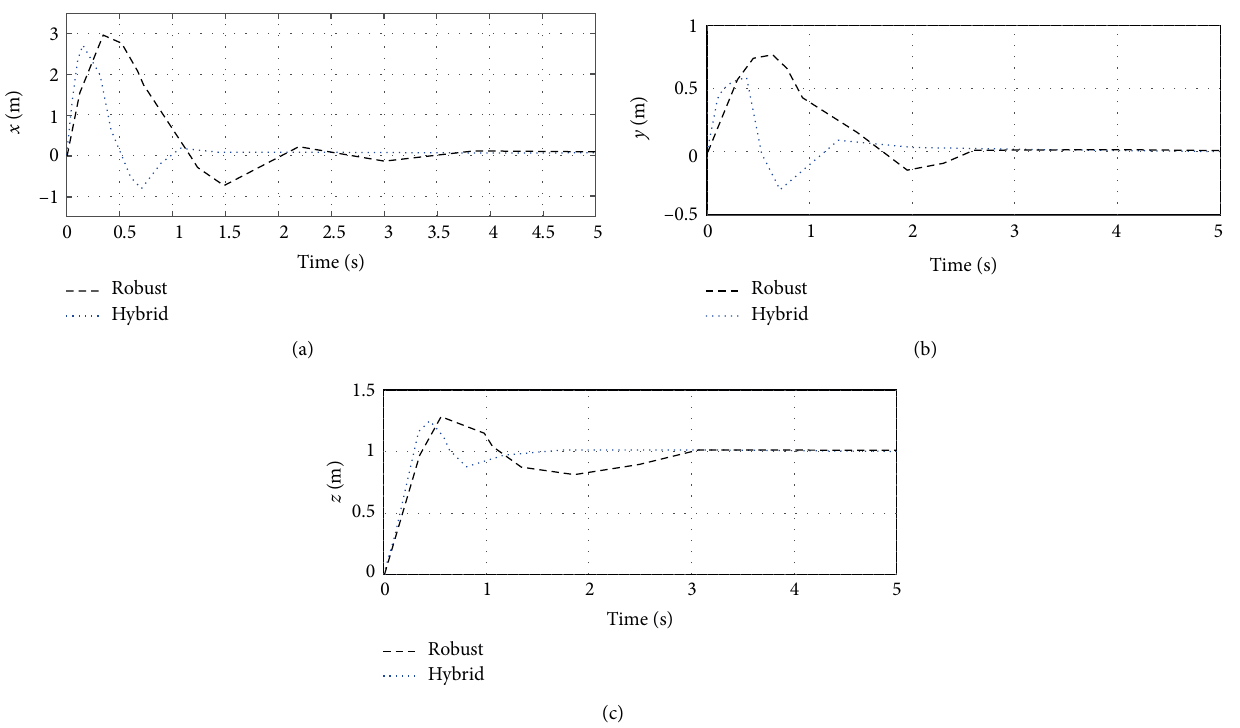
-position of UAV. (b) The 𝑥